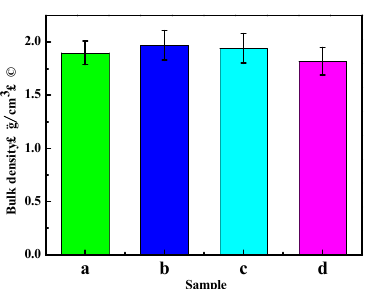
Figure 5. Water erosion depth of the MOC samples after different dry–wet cycles: (a) without dry– wet cycles; (b) one time; (c) two times; (d) three times.